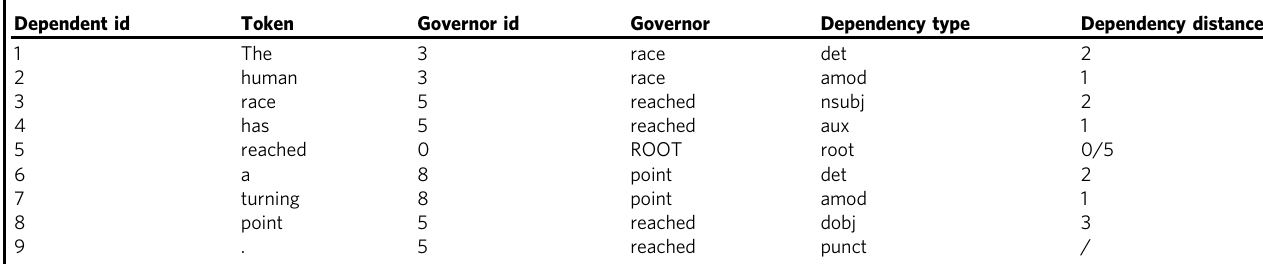
Table 1 Dependency relations of Example